Question: Summarize what this figure shows in one sentence.
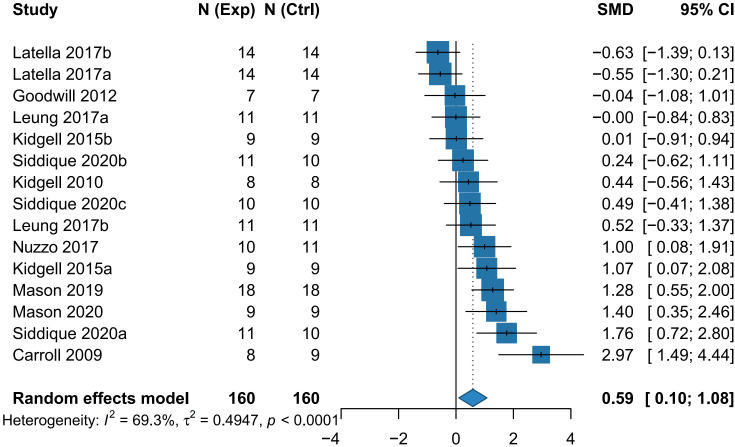
Answer: Forest plot of the pooled effects of exercise interventions on cortical excitability.